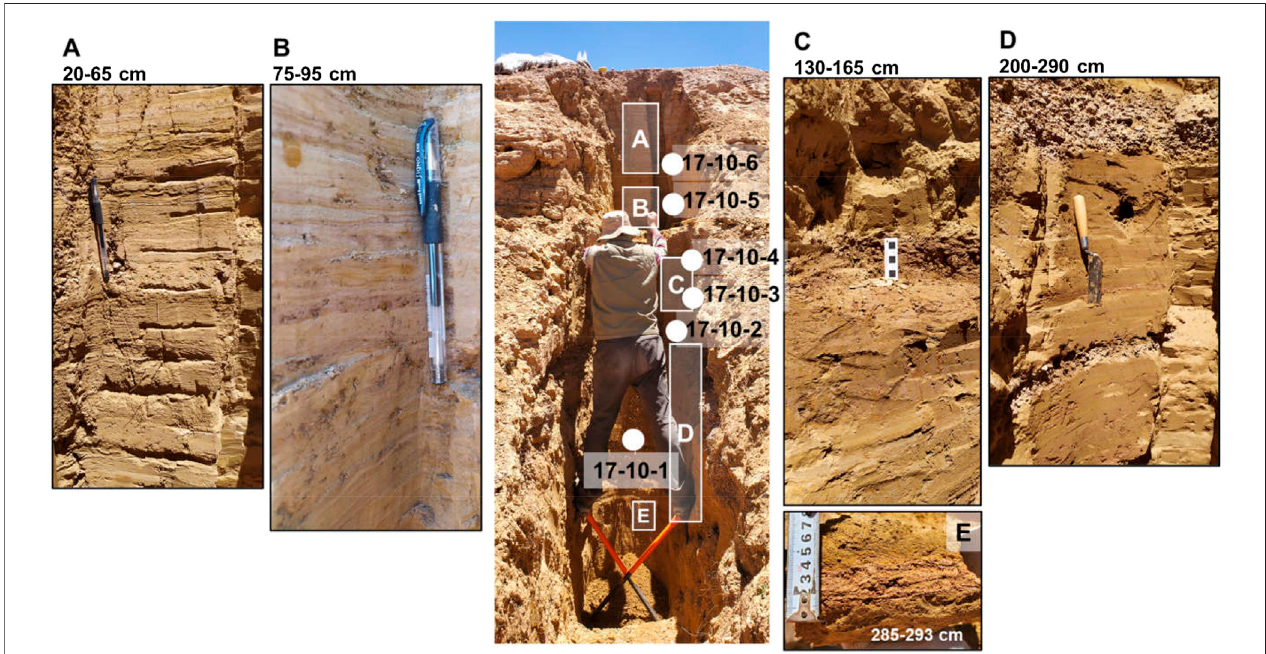
FIGURE 3 | Sedimentary structure details and composition of the 17 – 10 locality. The entire section is shown in the middle of the fi gure, with enlarged portions shown on the left and right sides.